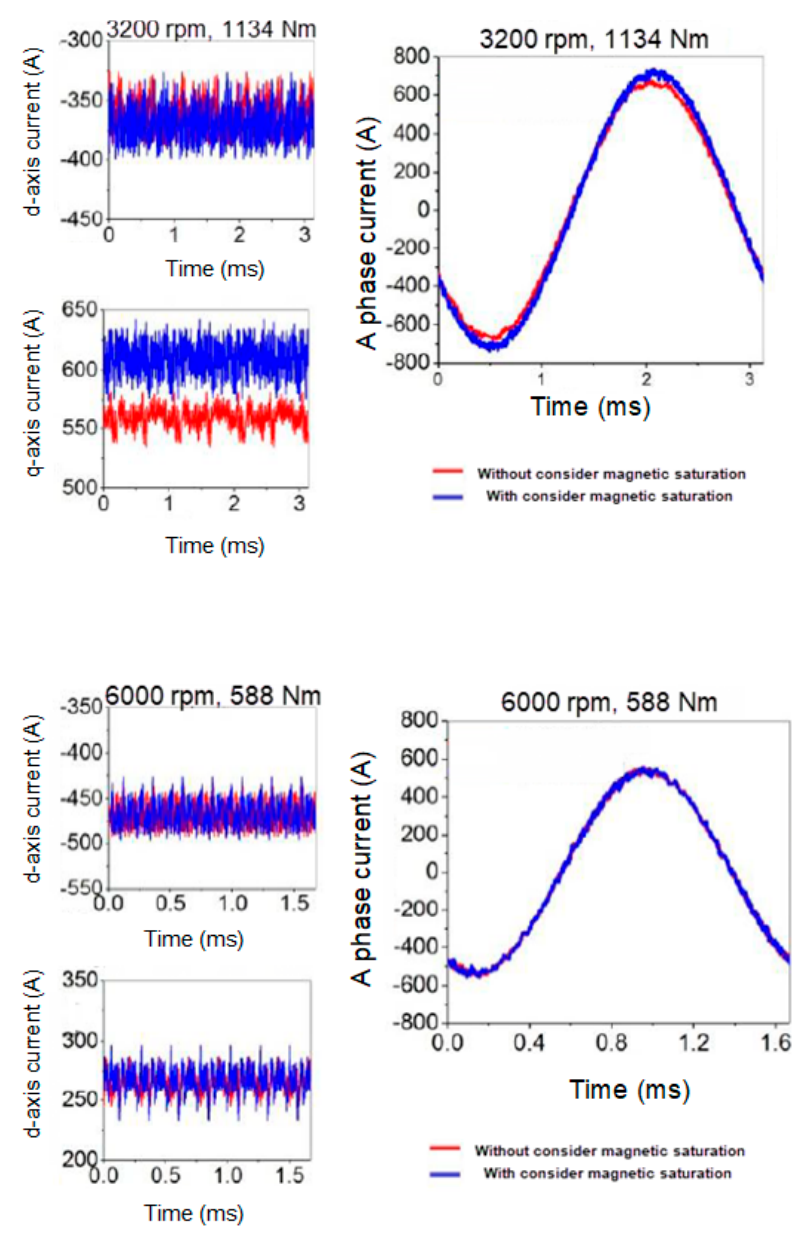
Figure 2. Phase current and dq-axis current under di ff erent working points of the